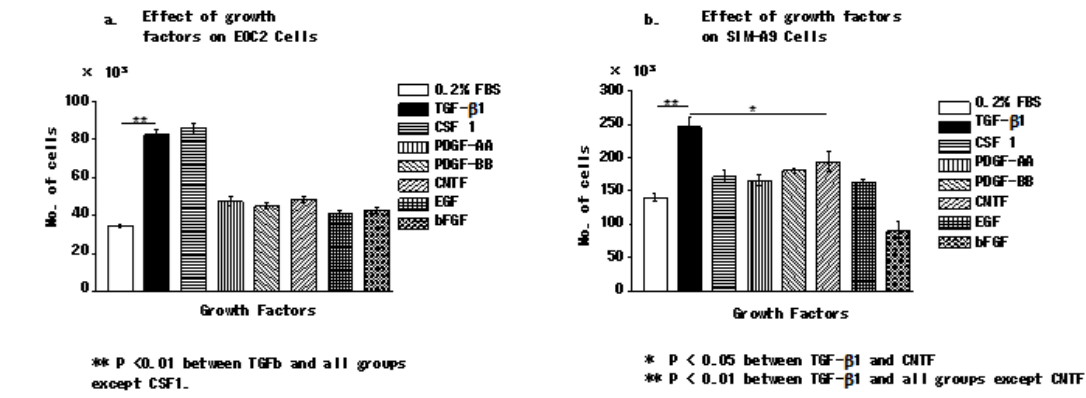
Figure 1. TGF- β promotes the proliferation of Figure 1. TGF-β promotes the proliferation of microglia.